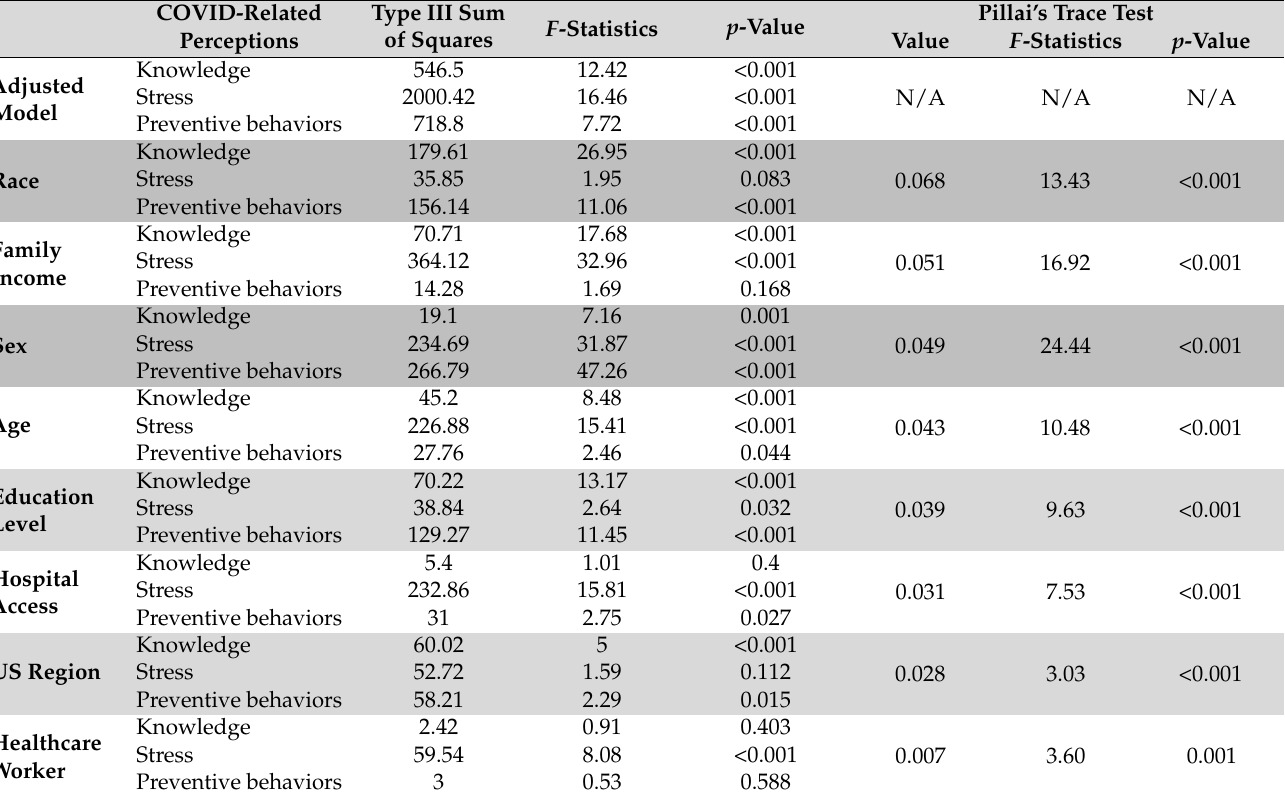
Table 4. The general linear model estimated the association between sociodemographic determinants and COVID-related perceptions (knowledge, stress, and preventive behavior). Pillai’s Trace test determined the level of significance of each contributor to the model. ( p < 0.05 is considered statistically